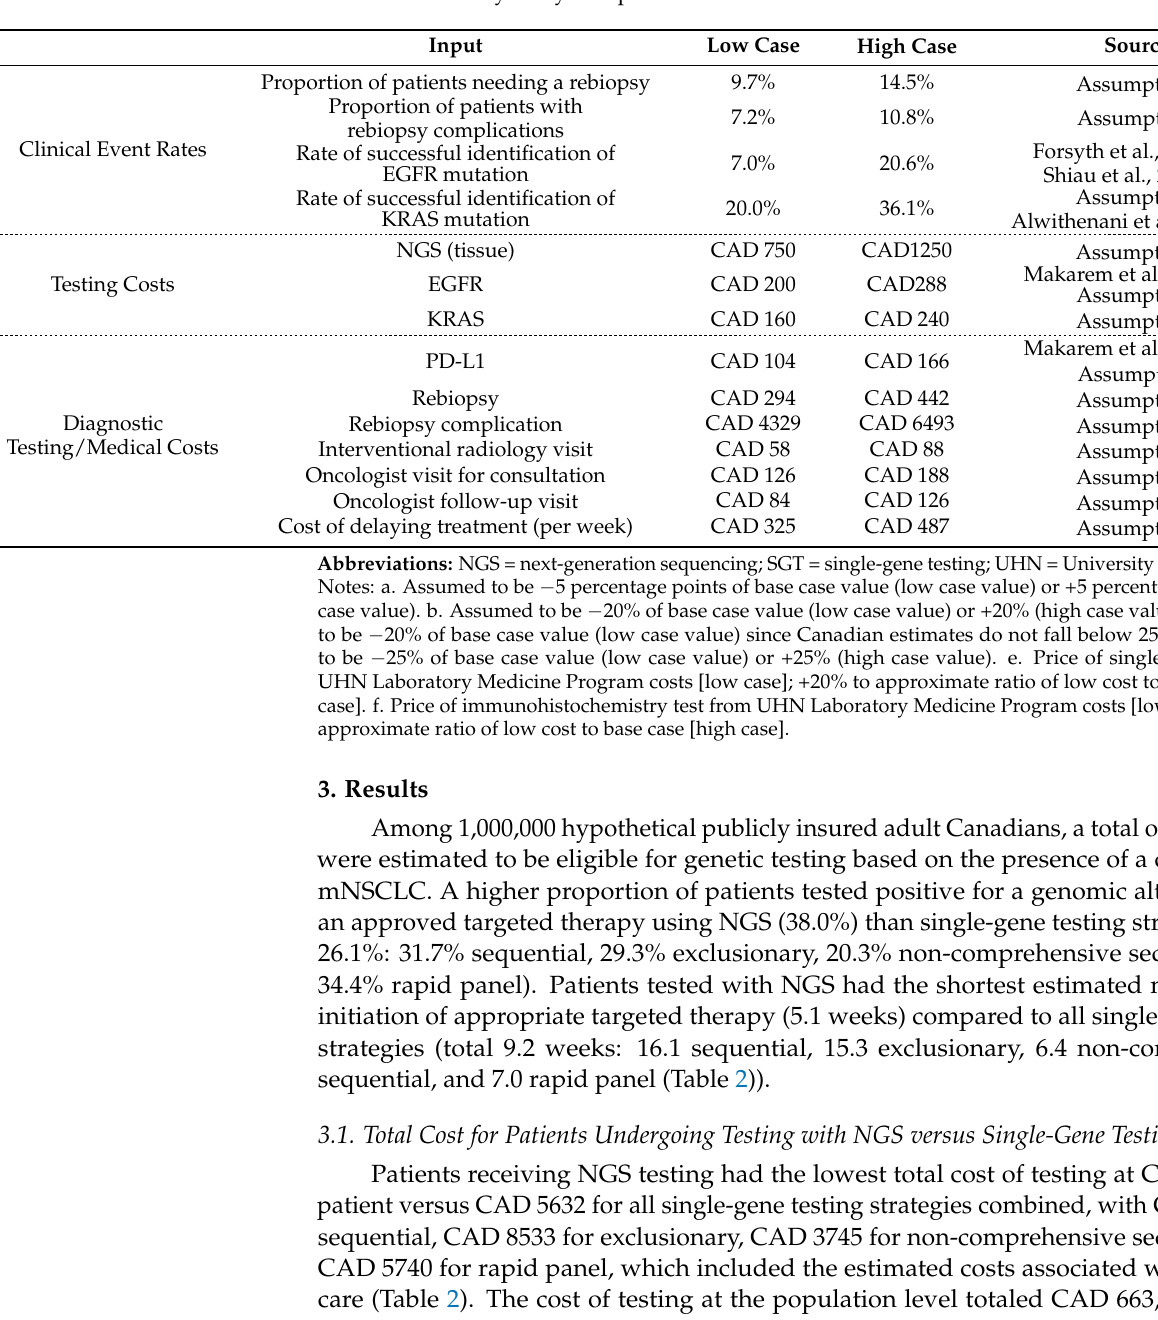
Table 3. Sensitivity analysis